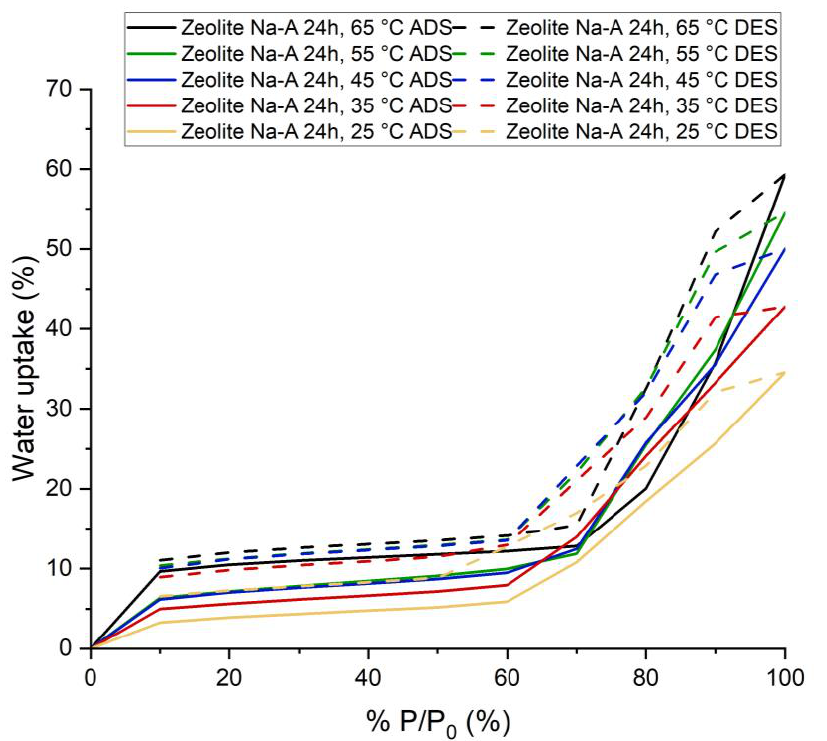
Figure 7. Adsorption and Desorption Isotherms for Synthesized Na-A Zeolite (12 h) at five process temperatures: 25, 35, 45, 55 and 65 °C.